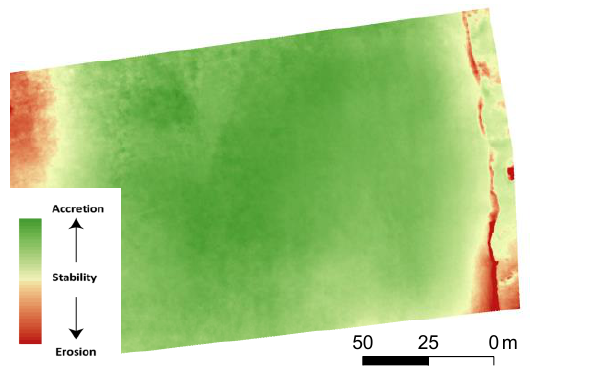
After a GIS treatment, polygons can be drawn on previous DDVMs.